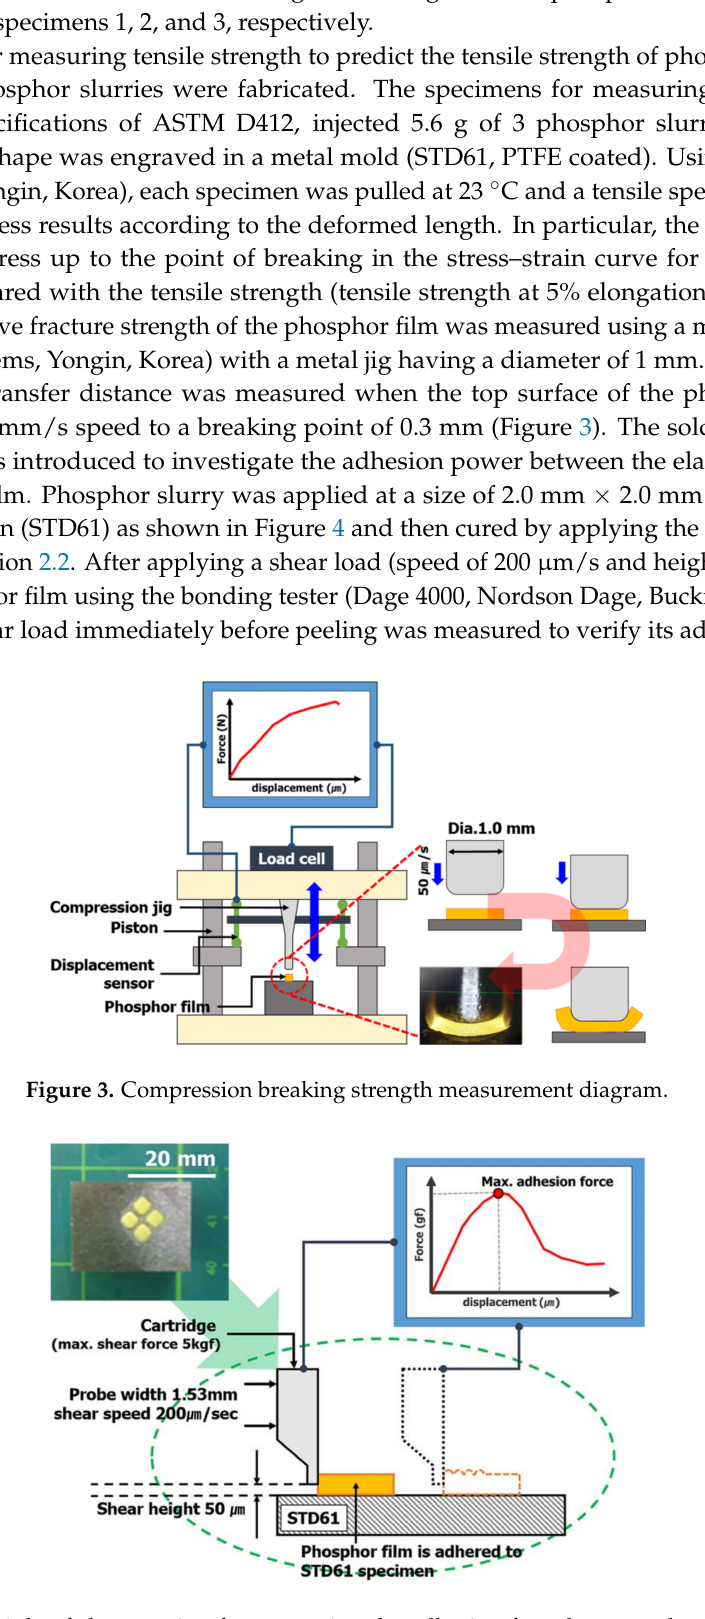
Figure 4. Principle of shear testing for measuring the adhesion force between the phosphor film and